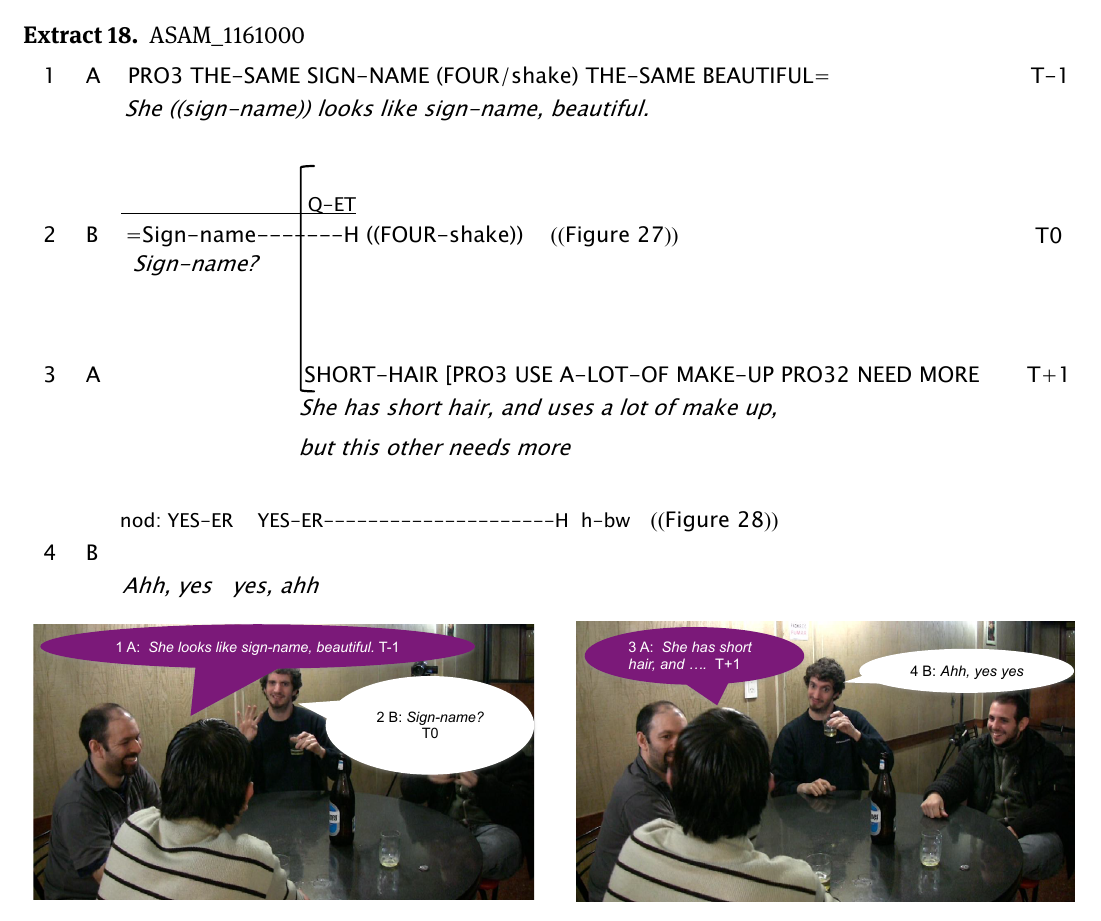
Figure 28. ‘Ahh!’ . Person B, middle, provides uptake of the OIR sequence in line